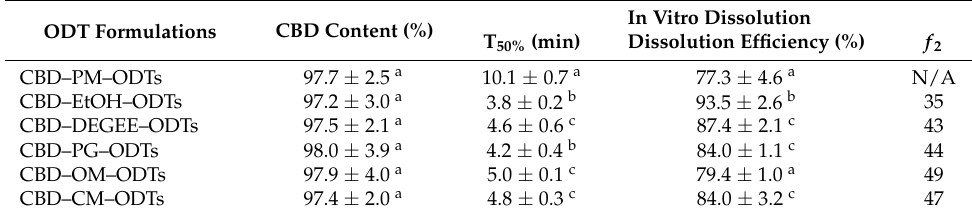
Table 4. CBD content and in vitro dissolution parameters of CBD ODTs containing 8% SSG and having the hardness of 31 ± 2